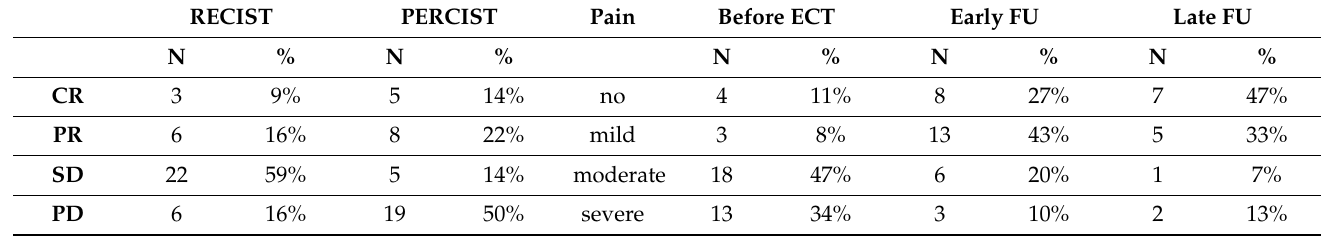
Table 3. Response to treatment according to RECIST and PERCIST criteria, and pain pre- and post-ECT (at early and at late